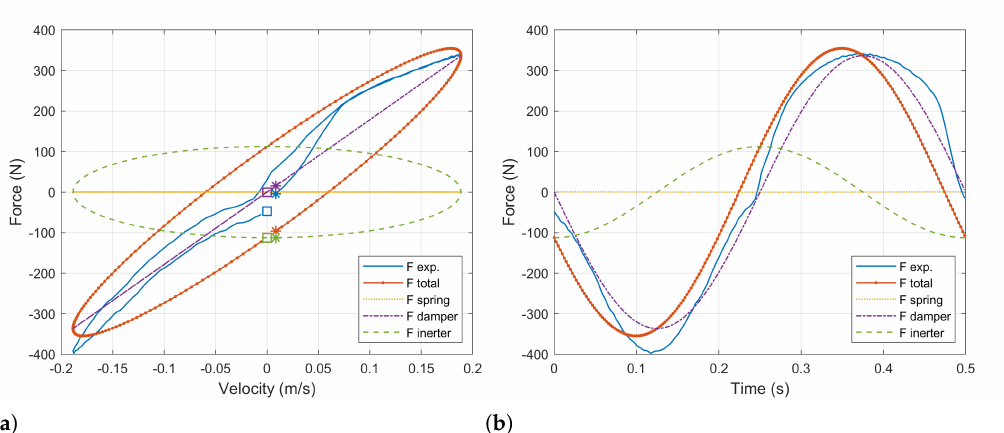
Figure 4. ( a ) Force–velocity and ( b ) force–time diagrams of the ball-screw damper with a constant external resistance R e = 10 Ω compared to the experimental data of the baseline damper. The ball- screw damper’s force is decomposed into its components corresponding to the equivalent sprint, damper and